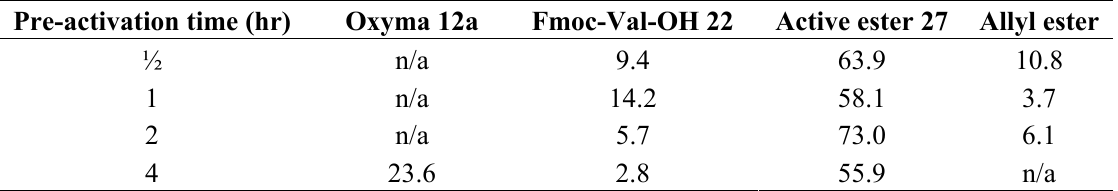
Table 6. The rate of formation of the active ester of Fmoc-Val-OH 22 using ethyl 2-(allyloxycarbonyloxyimino)-2-cyanoacetate ( 18 ). Pre-activation time (hr)